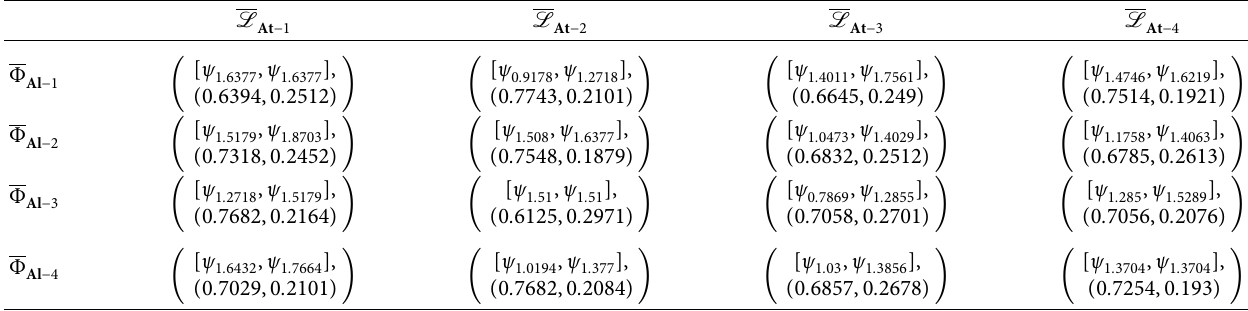
Table 14: Aggregated decision matrix of the expert by CIULWAHM